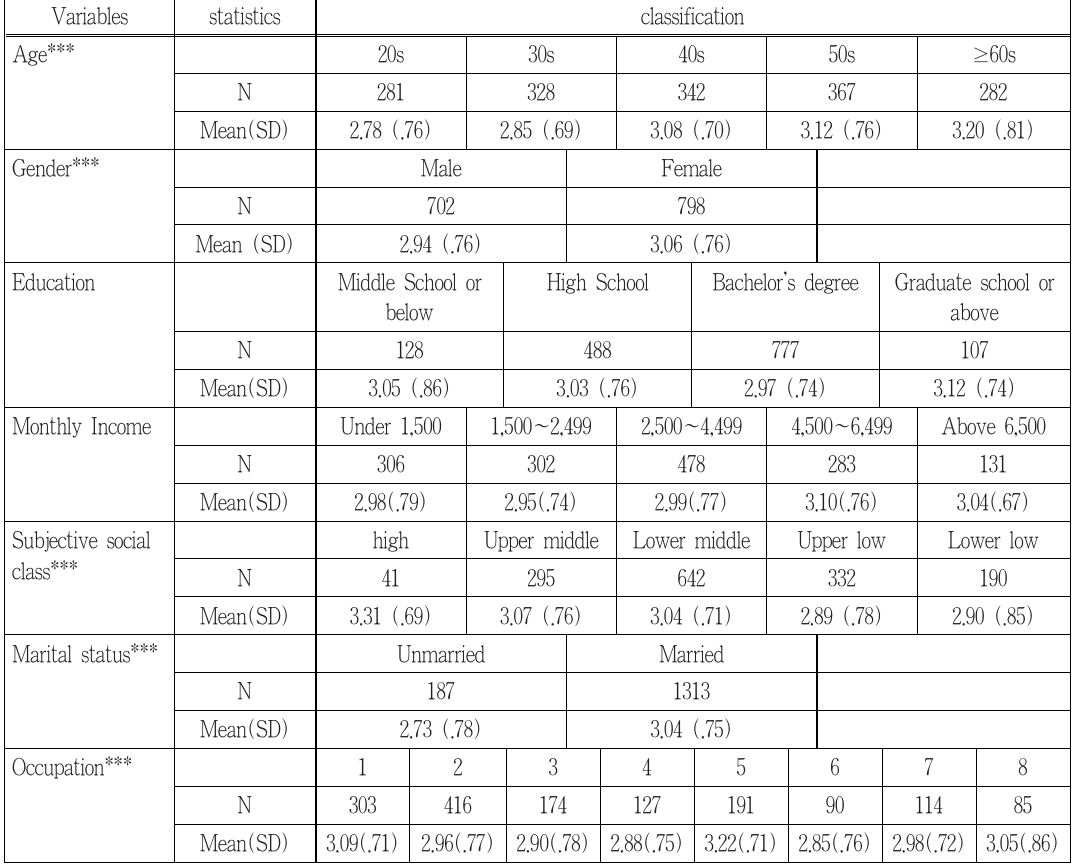
<Table 2> Socio-demographics and Practices of Green